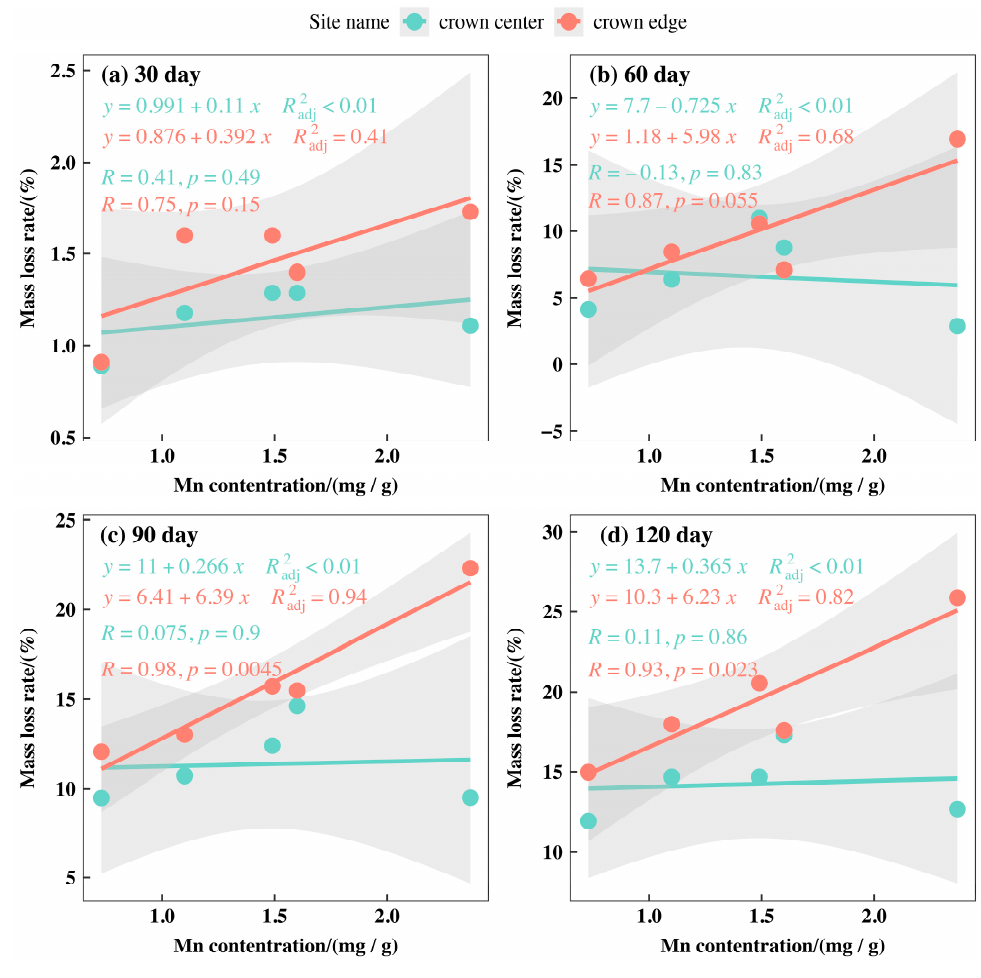
Figure 14. Linear relationships between initial litter Mn concentration and accumulated mass loss for each sampling day of CC and CE. ( a ) The linear relationship between initial litter Mn concentration and accumulated mass loss in 30 days. ( b ) The linear relationship between initial litter Mn concen- tration and accumulated mass loss in 60 days. ( c ) The linear relationship between initial litter Mn concentration and accumulated mass loss in 90 days. ( d ) The linear relationship between initial litter Mn concentration and accumulated mass loss in 120